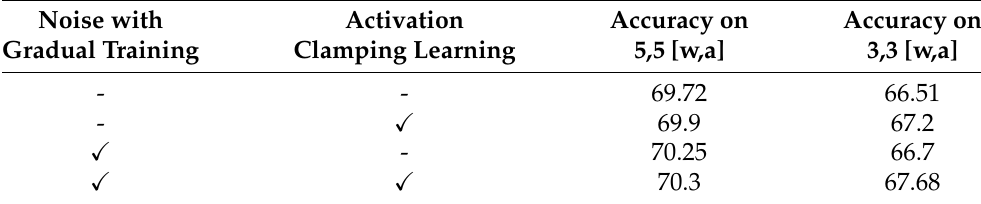
Table 4. Ablation study of NICE scheme. Accuracy (% top-1) for ResNet-18 on ImageNet for different